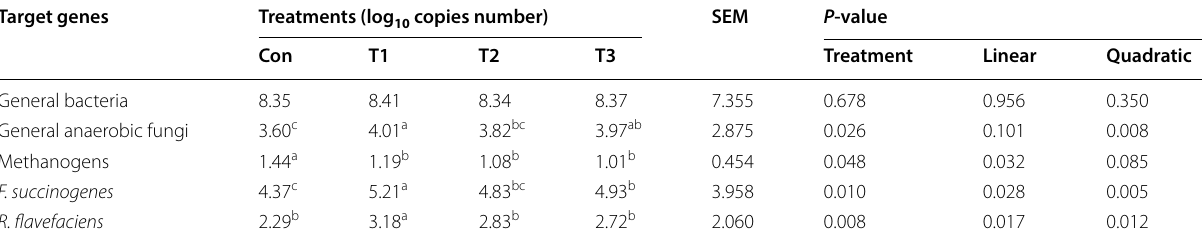
Table 4 Quantification of general bacteria, general fungi, methanogens, Fibrobacter succinogenes , and Ruminococcus flavefaciens by real-time